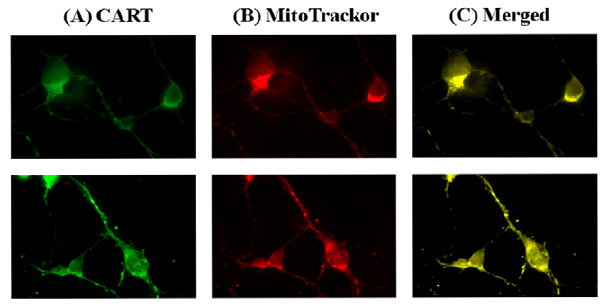
Figure 3. Mitochondrial localization of CART in primary neuronal cells. Mouse cortex neurons (upper panel) and hippocampal neurons (bottom panel) at 7-day in vitro were incubated with MitoTracker Red. The cells were fixed and incubated with a CART specific antibody and secondary antibody, finally treated with tyramide- conjugated fluorescent dye Alexa 488 (green) and photographed using a fluorescence microscope at 100 6 magnification. (A) shows CART antibody staining (green), (B) shows mitochondrial staining (red), and (c) is merged image (yellow), demonstrating the co-localization of CART and mitochondria.